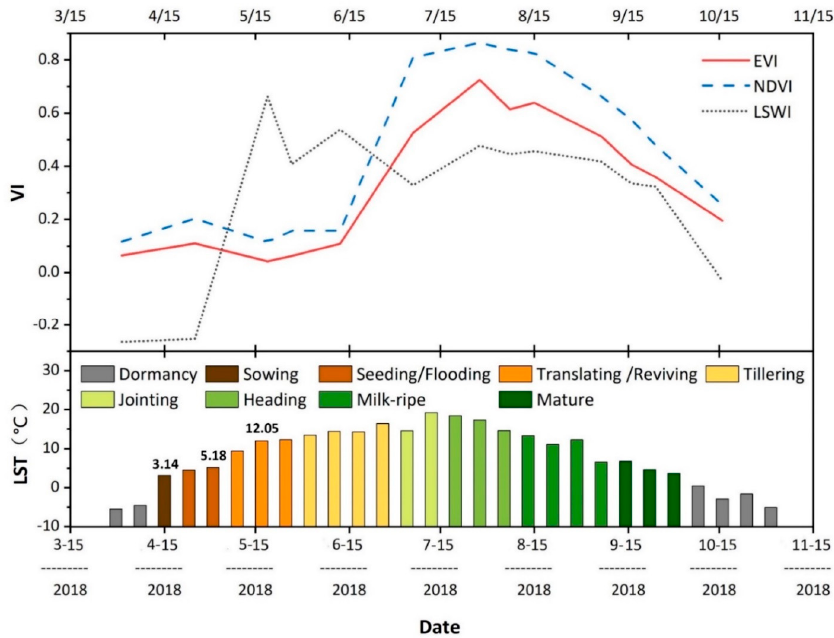
Figure 8. The temporal profile of paddy rice VIs (NDVI, EVI, and LSWI) at the AOIs, the nighttime LST, and the crop calendar are shown in the figure. The nighttime LST first over 0 ◦ C, 5 ◦ C, 10 ◦ C are marked.